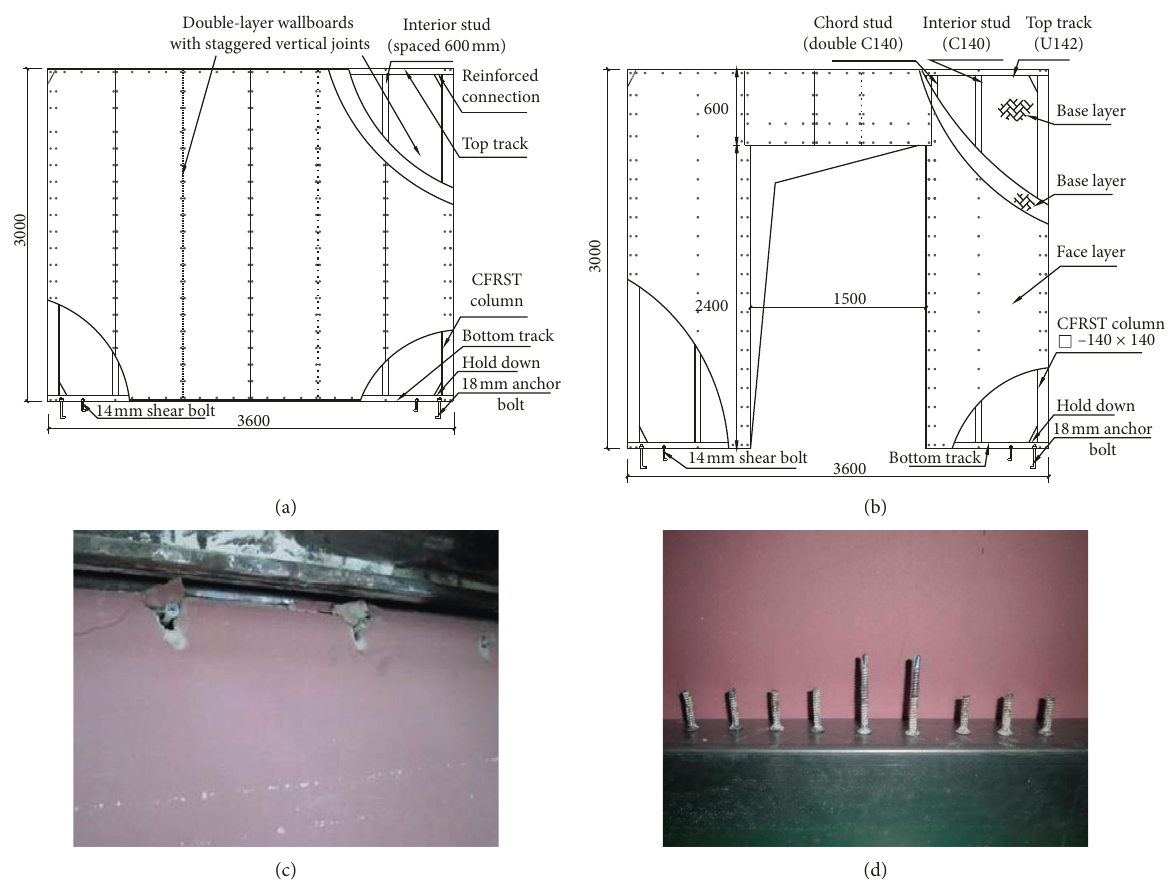
Figure 4: Details of specimens [18]. (a) Typical full-sheathed RCFS shear wall. (b) Typical perforated RCFS shear wall. (c) Failure Mode 1. (d) Failure Mode